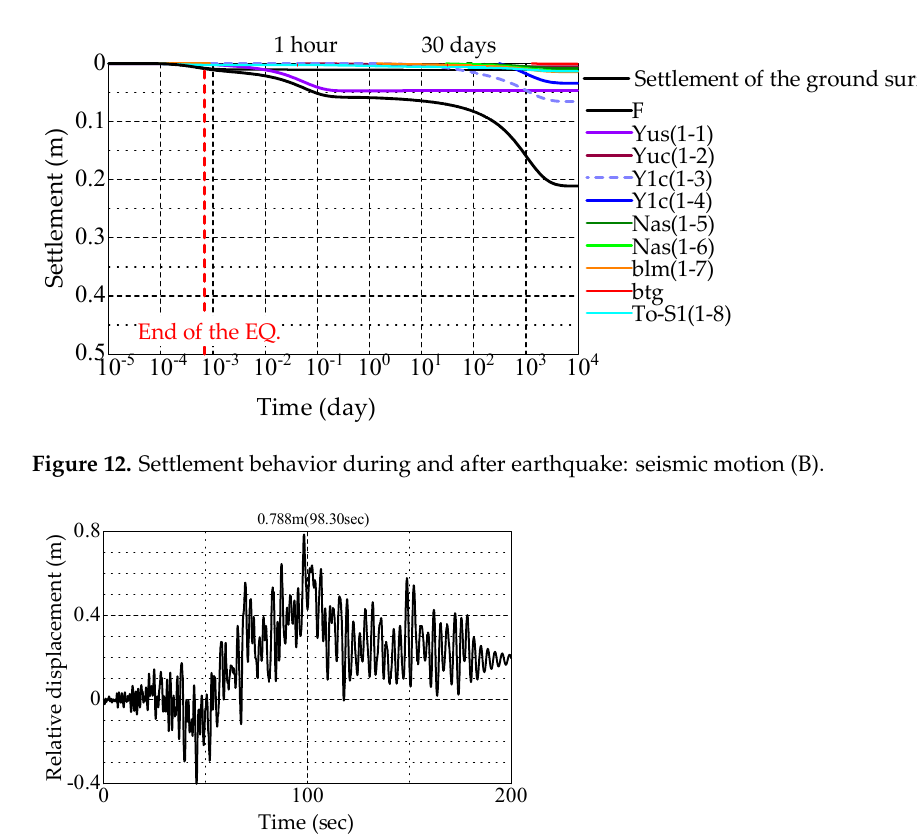
Figure 11. Settlement behavior during and after earthquake: seismic motion (A).